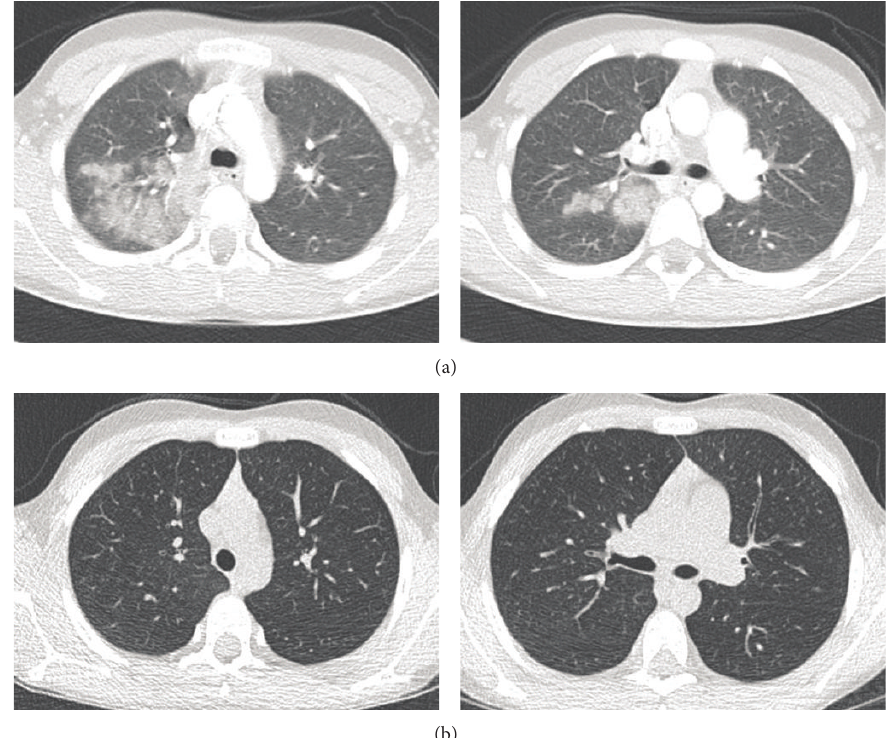
Figure 2: (a) Initial chest CT with upper and lower right lobe consolidations, characterized by low density ( − 129HU within the lower lobe consolidation). (b) Chest CT two months later showed complete